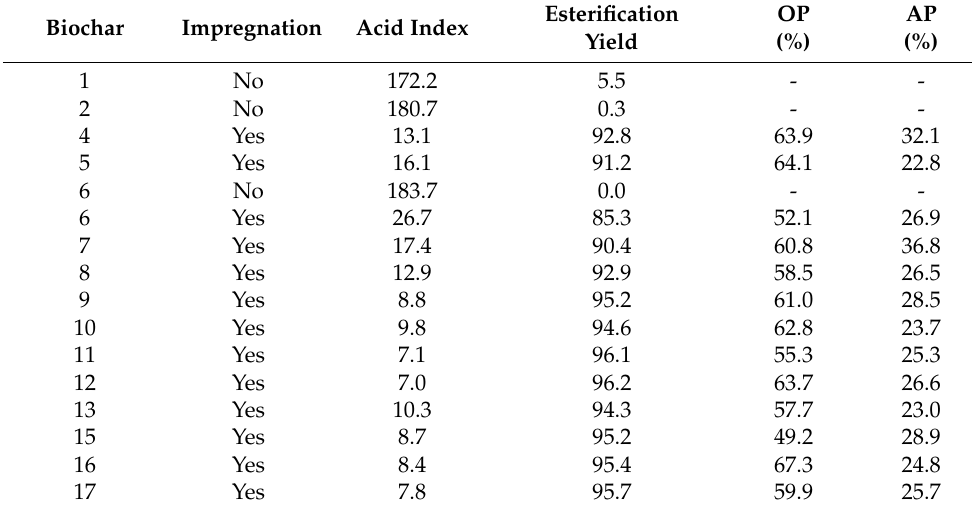
Table 4. Resulting acid index, esterification yield, and percentages of organic (OP) and aqueous (AP) phases obtained after